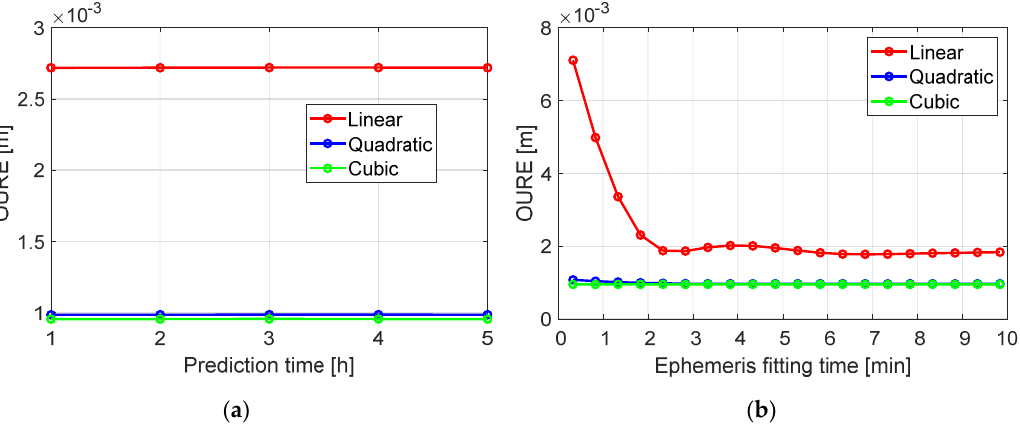
Figure 15. The OUREs of the polynomial fitting errors when the beginning of the fitting interval corresponds to ( a ) different prediction times and ( b ) different ephemeris fitting times of the Level A products.